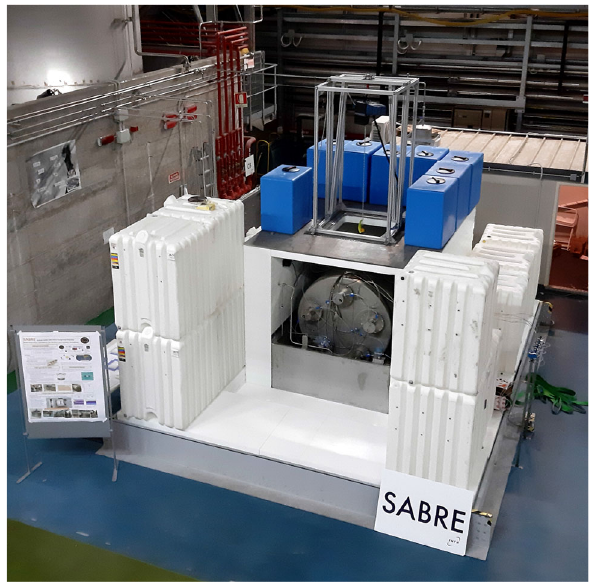
Fig. 3 The SABRE-PoP setup under construction in LNGS Hall-C